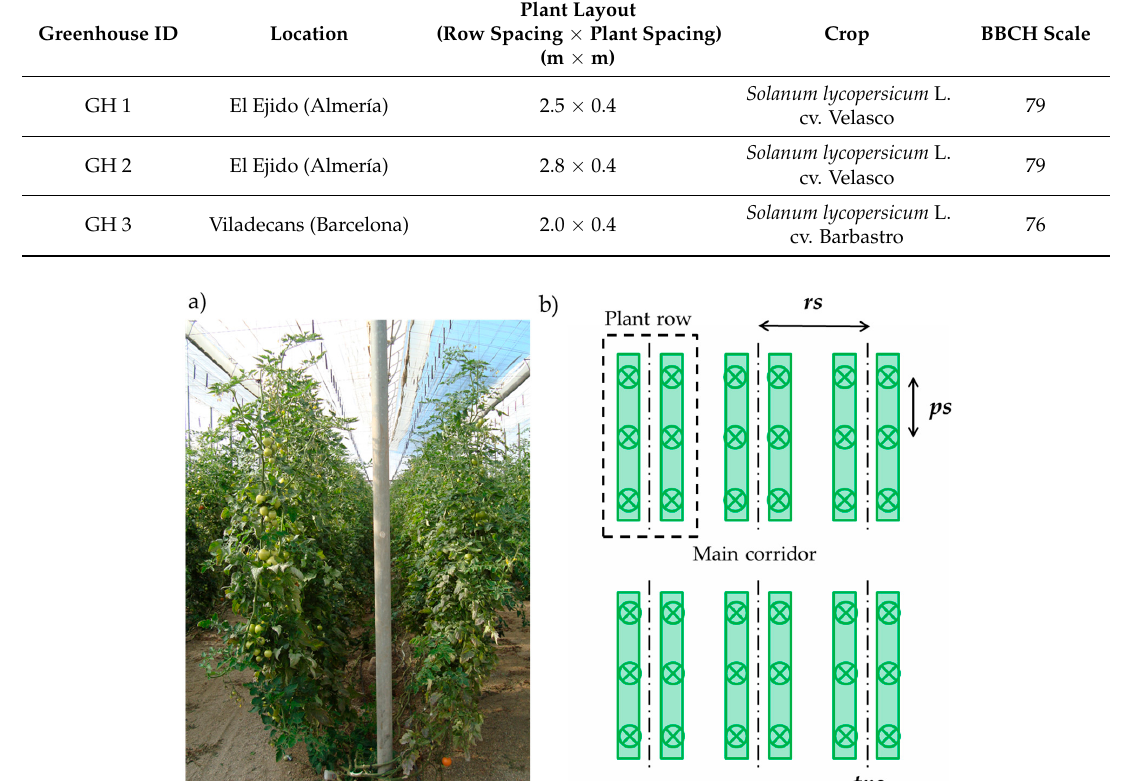
Table 1. Main characteristics of the experimental fields.